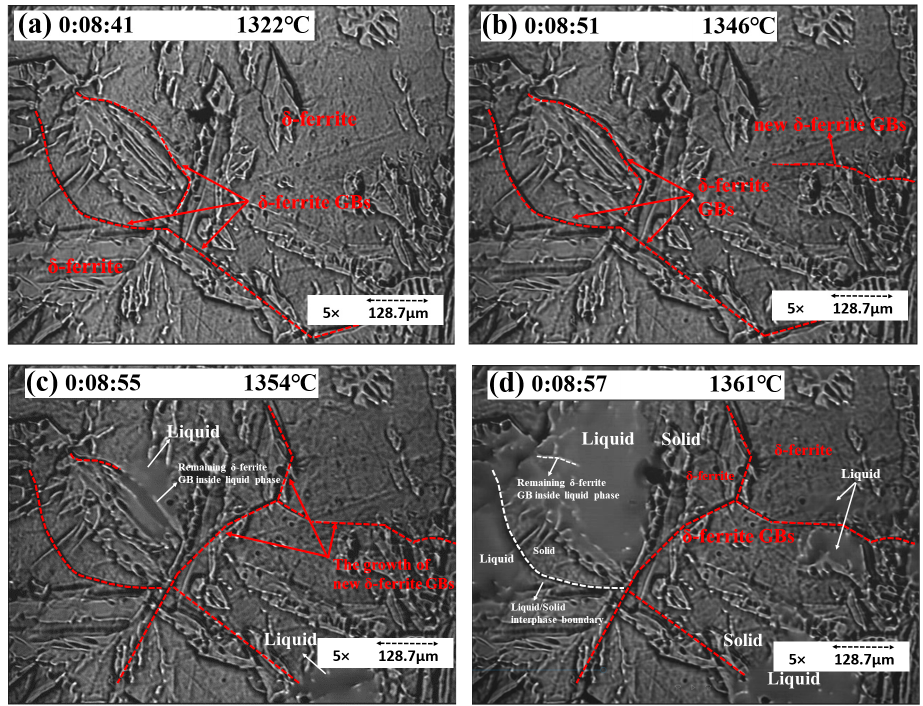
Figure 6. Concentric HTCM images revealing ( a – c ) the growth of δ GBs before melting and ( d ) the location of the liquid phase.